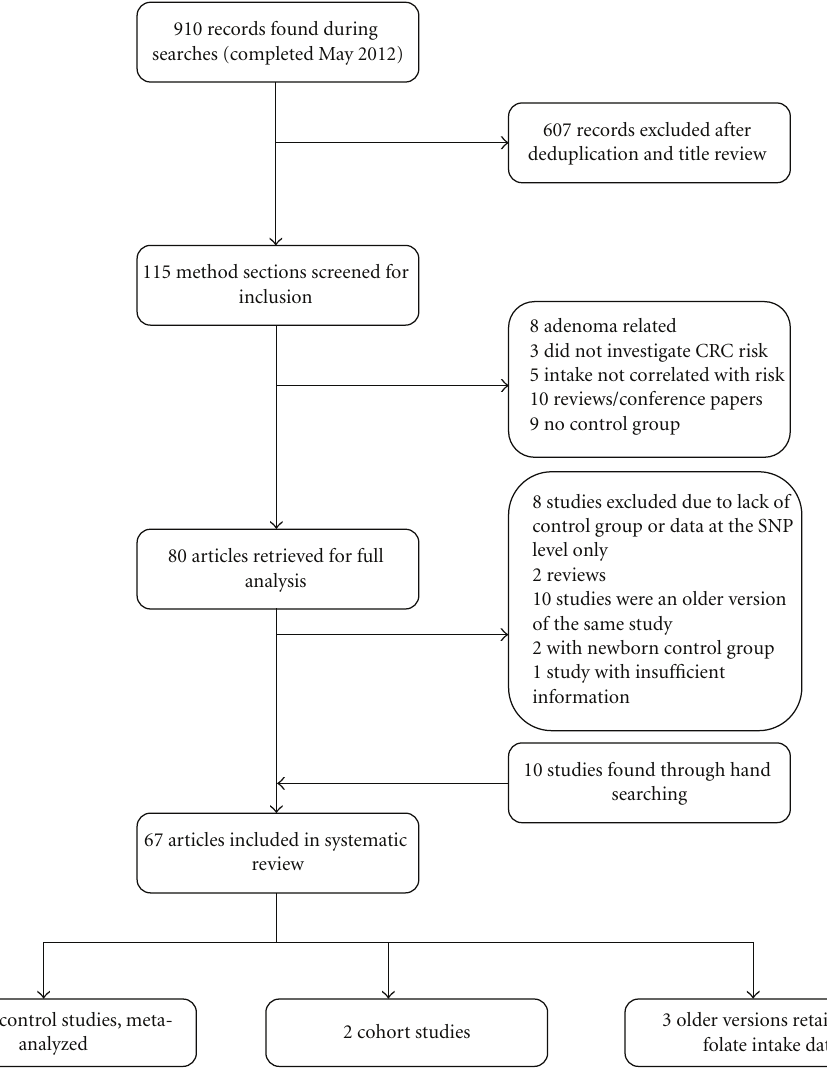
Figure 1: Search strategy flow